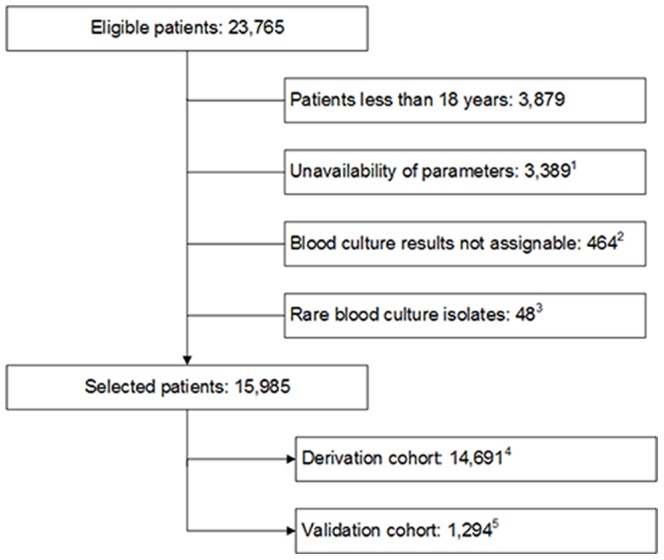
Selection process of the study population.
1unavailability of laboratory variables, 2Contaminations or fungal growth, 3blood culture results with less than 0.001% frequency, 4study patients treated between Jan 1, 2006 and Jul 31, 2010, 5study patients treated between Aug 1, 2010 and Dec 31, 2010.